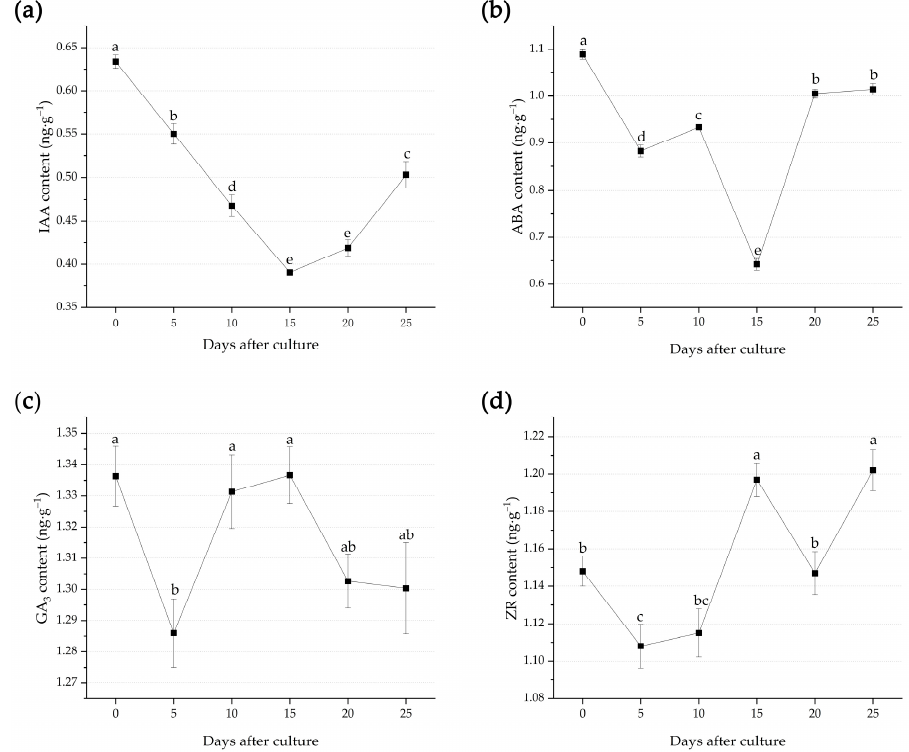
Figure 4. Changes in IAA, ABA, GA 3 , and ZR quantifications during rooting of B. buttiana ‘Miss Manila’. ( a ) IAA contents. ( b ) ABA contents. ( c ) GA 3 contents. ( d ) ZR contents. Data present the means of three replicates ± SE. Letters on the top of each point show p < 0.05; the same letters show days after